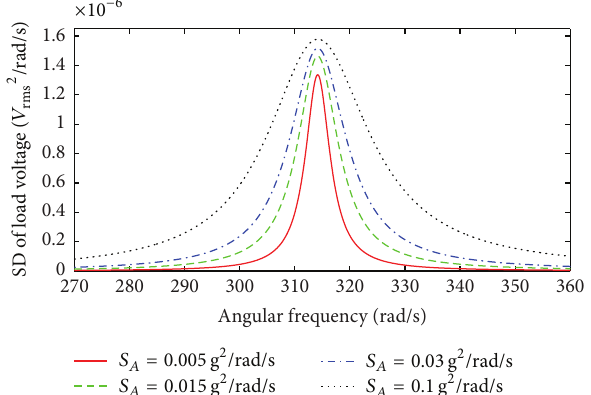
Figure 14: Equivalent frequency as a function of SD of acceleration for several values of the damping scaling factor 𝛼 with 𝜂 = 5 m −2 .